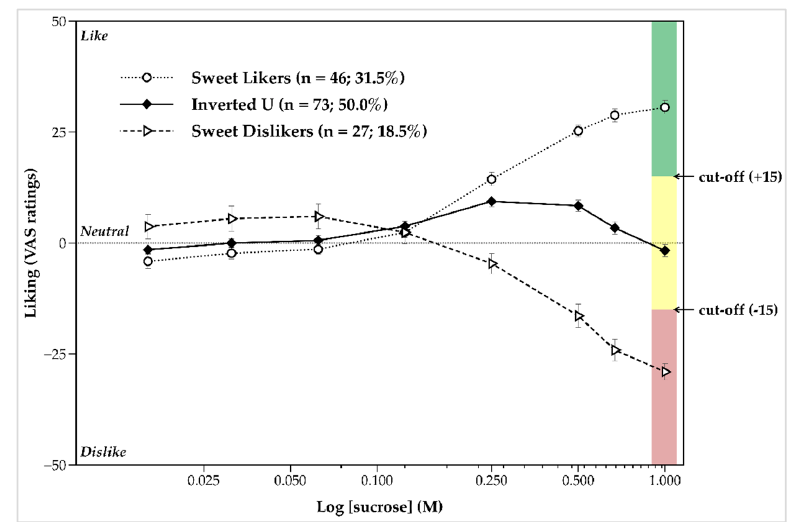
Figure 3. Liking ratings (mean ± standard error of the mean) as a function of sucrose solutions by the three sweet taste liker phenotypes. Ratings were averaged across the two taste test blocks. The response pattern for the sweet liker phenotype is displayed with a dotted line, the response pattern of inverted U-shaped phenotype with a solid line, and the response pattern of sweet disliker phenotype with a dashed line. Different colors denote the different ranges of liking ratings for 1 M sucrose which, according to the relevant sensitivity and specificity checks (see Tables 2 and 3 for details), could be used for the reliable discrimination between the three distinct sweet taste liker phenotypes: green color corresponds to the range of liking ratings for 1 M sucrose representing sweet likers, yellow color indicates the hedonic response spectrum to 1 M sucrose characteristic of the inverted U-shaped phenotype, and red color corresponds to the range of liking ratings for 1 M sucrose for sweet dislikers.